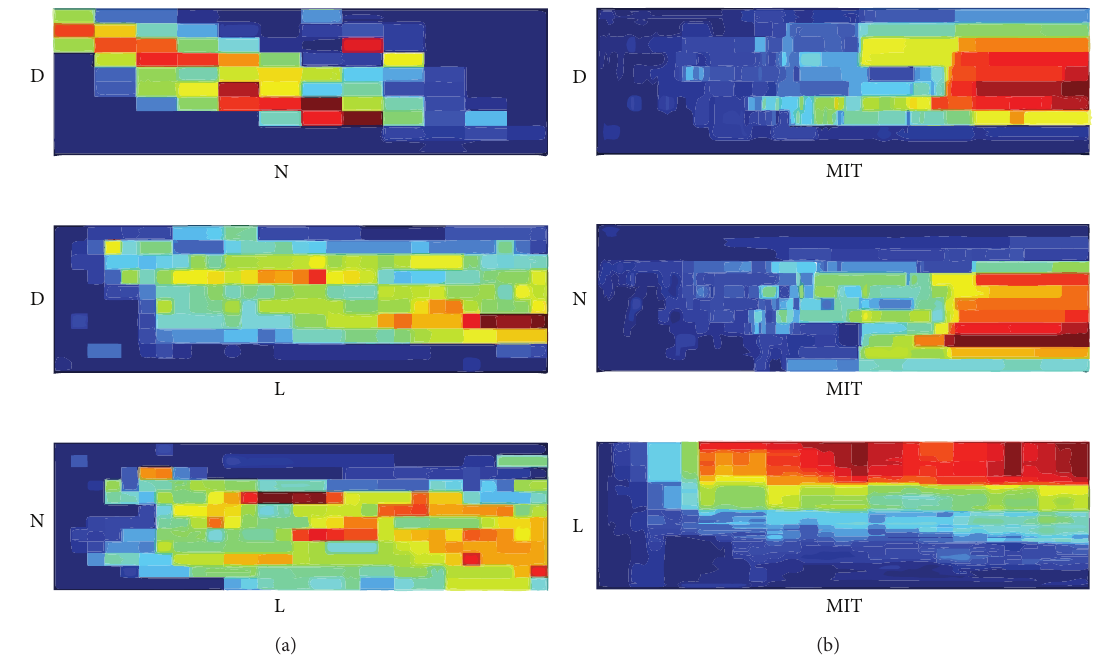
Figure 11: A method to attempt to visualize elements of the 4-dimensional parameter space. For each panel, two of the four parameters are varied over their entire domain. The color associated with a particular point in the plane represents the probability that an arbitrary set of the other two parameters will result in a plausible designation. Red corresponds to higher probabilities (around 0.25) whereas blue corresponds to lower probabilities (near